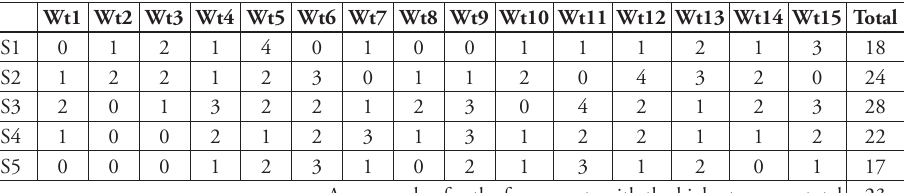
Table 10. Example of calculation of the reference value for the monitoring of R. alpina in one site in one year (Wt: wild tree, S: